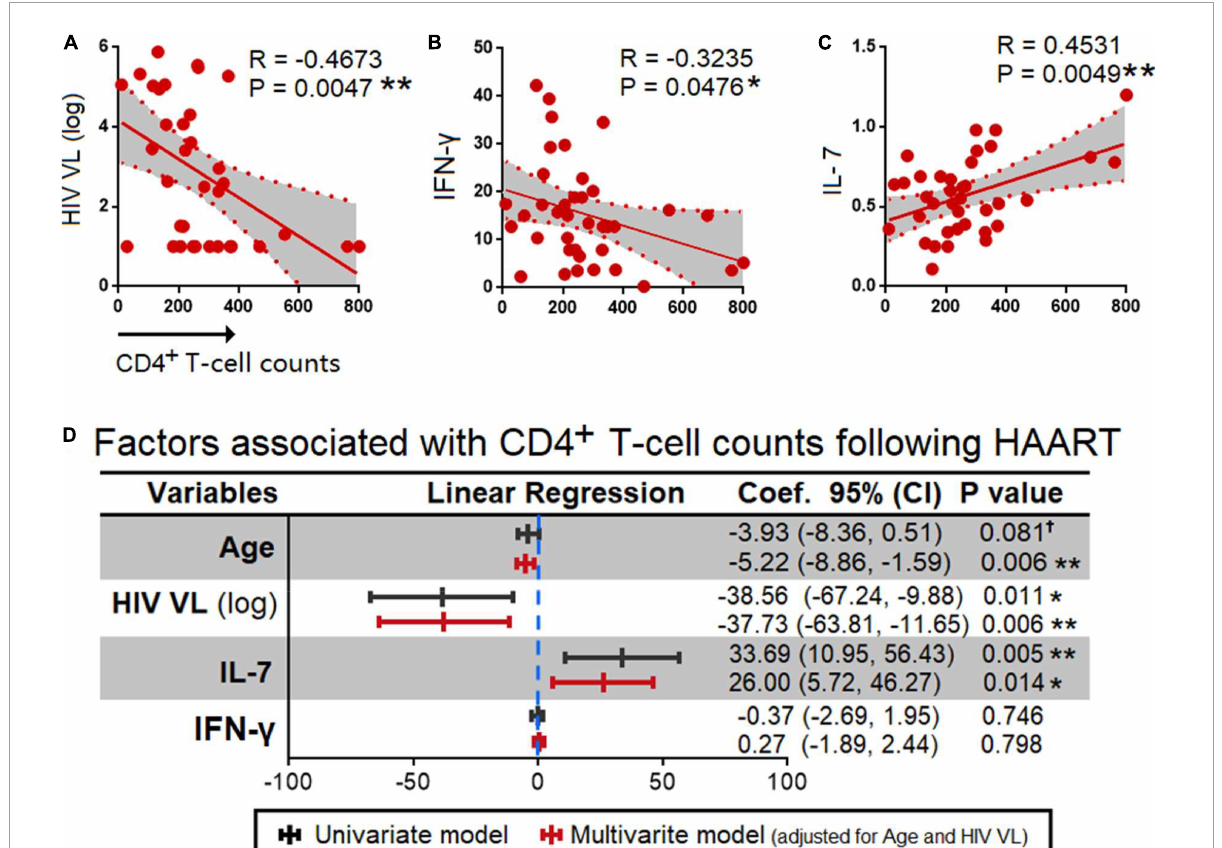
FIGURE5 Correlation between HIV plasma viral loads, and cytokines. Spearman correlation (A) HIV PVL and (B) IFN- γ that had an inverse correlation and (C) IL-7 that had a positive correlation with CD4+ T cell counts. The exact R- and P -values were calculated. (D) Association between age, HIV viral load (log), IL-7, and IFN- γ with CD4+ T cell counts. P -values < 0.05 are considered significant in all tests; * p < 0.05, ** p < 0.01. HAART, highly active anti-retroviral therapy; HIV, human immunodeficiency virus; VL, viral load, † , having a trend of